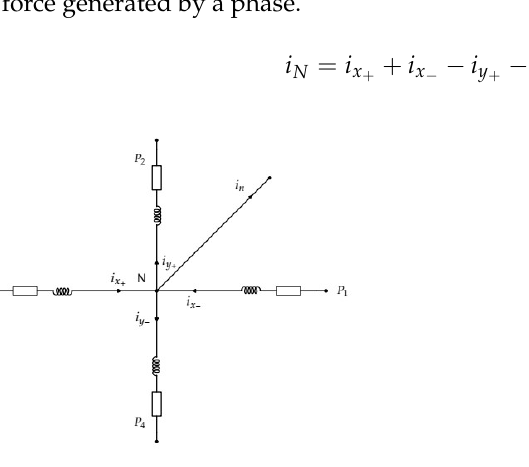
Figure 4. Equivalent circuit diagram of the proposed star